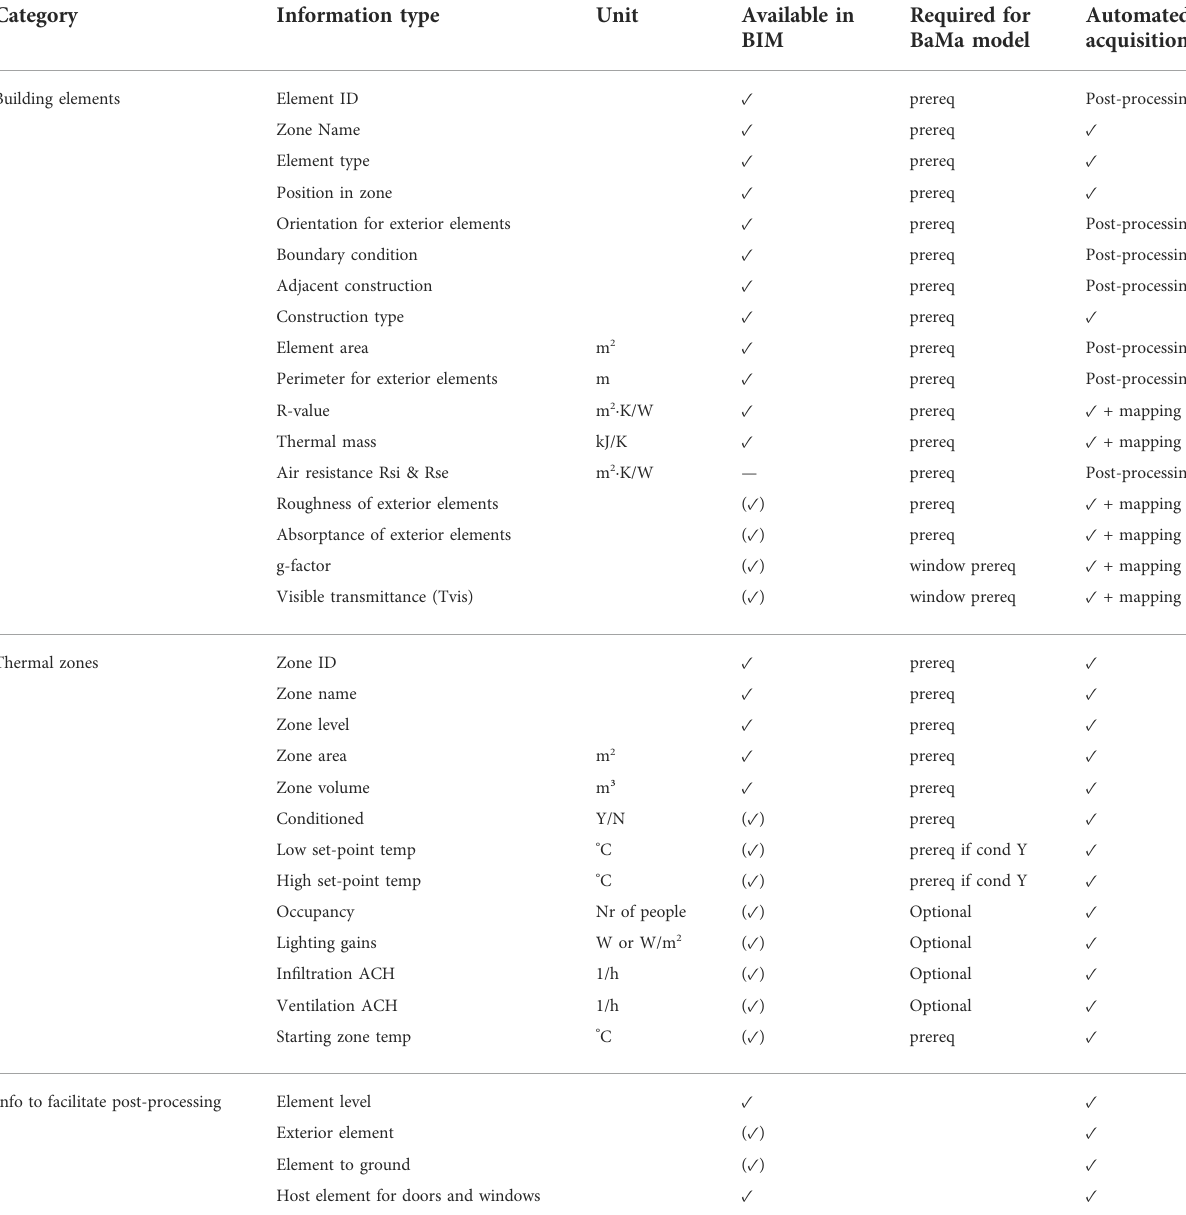
TABLE 1 Data exchange requirements from BIM to